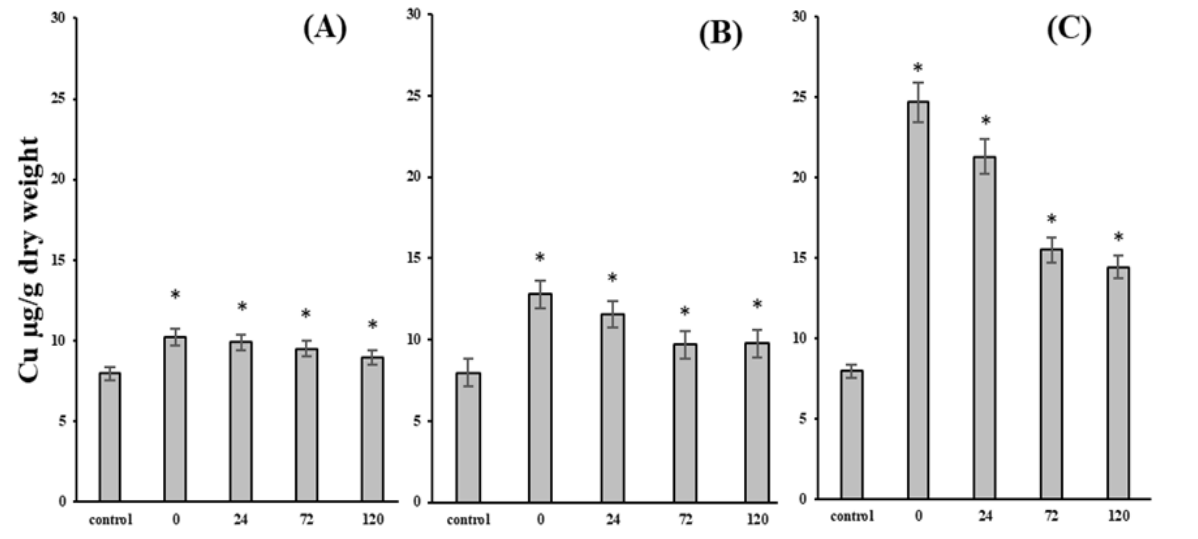
Figure 1. Copper content in the gills of M. trossulus under copper (Cu 2 + ) accumulation conditions and after depuration. ( A – C )—exposure to Cu 48, 96, 168 h, respectively; 0, 24, 72, 120 h—depuration (mean ± standard deviation). * Difference from the control is significant ( p < 0.05).